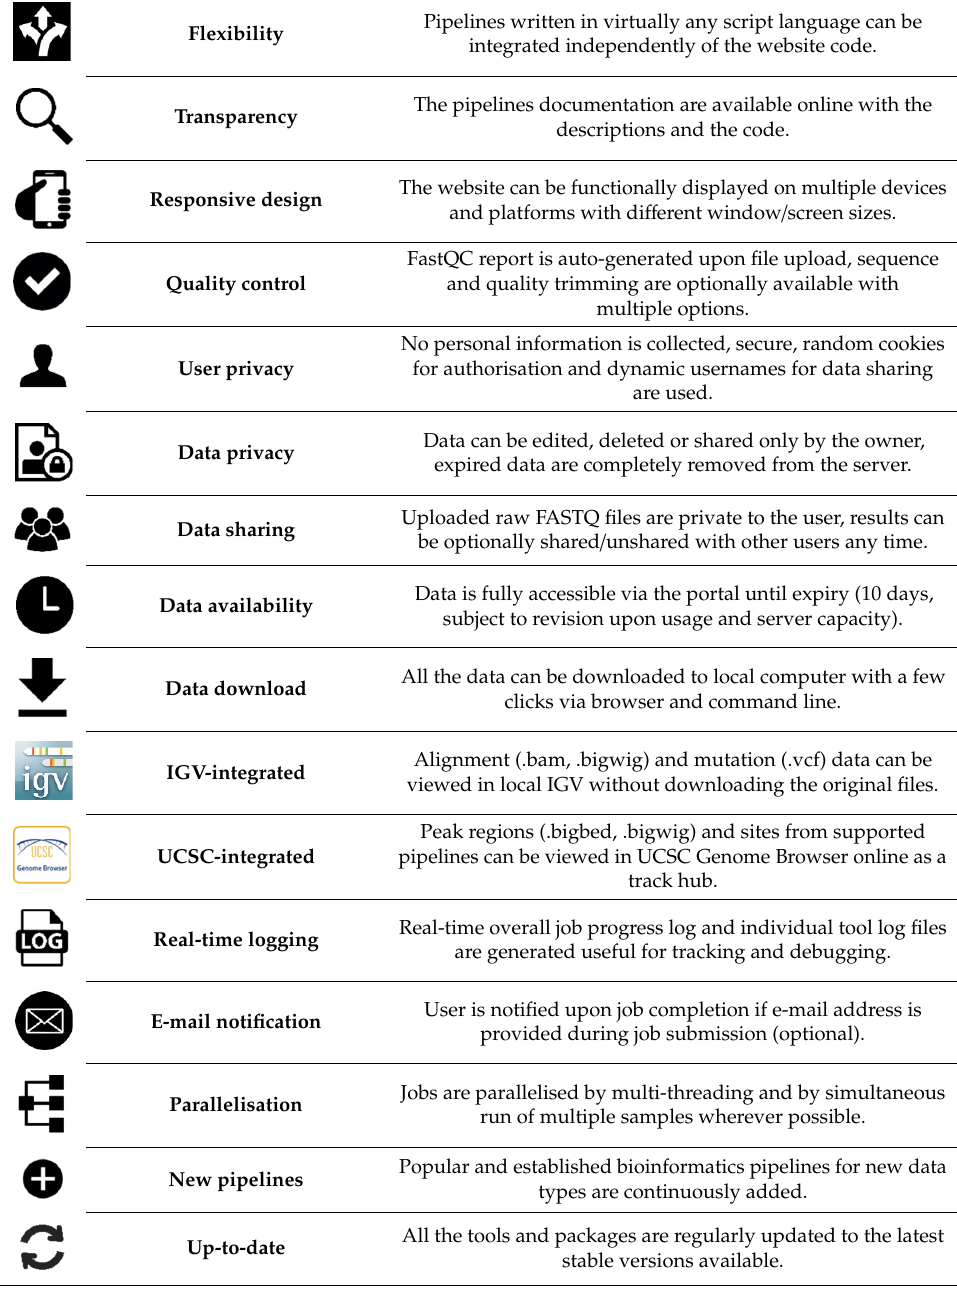
Table 2. Features of CSI NGS Portal.